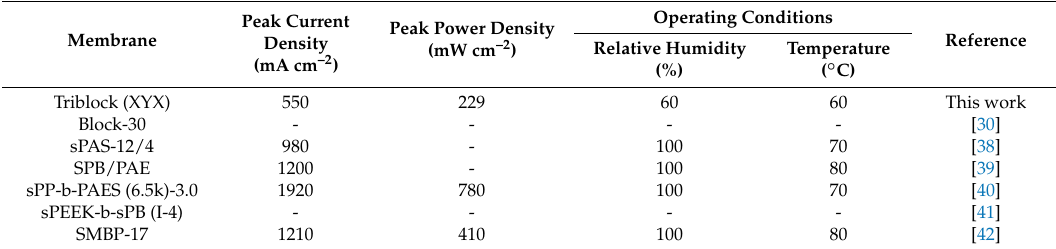
Table 3. Comparison table of performance of various block copolymer PEMs Membrane